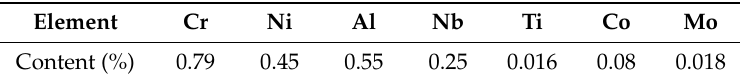
Figure 8. Finite element analysis models of contour milling ( a ) and ramp milling ( b ). Table 2 . Chemical compositions of the Inconel 718 (wt. %).